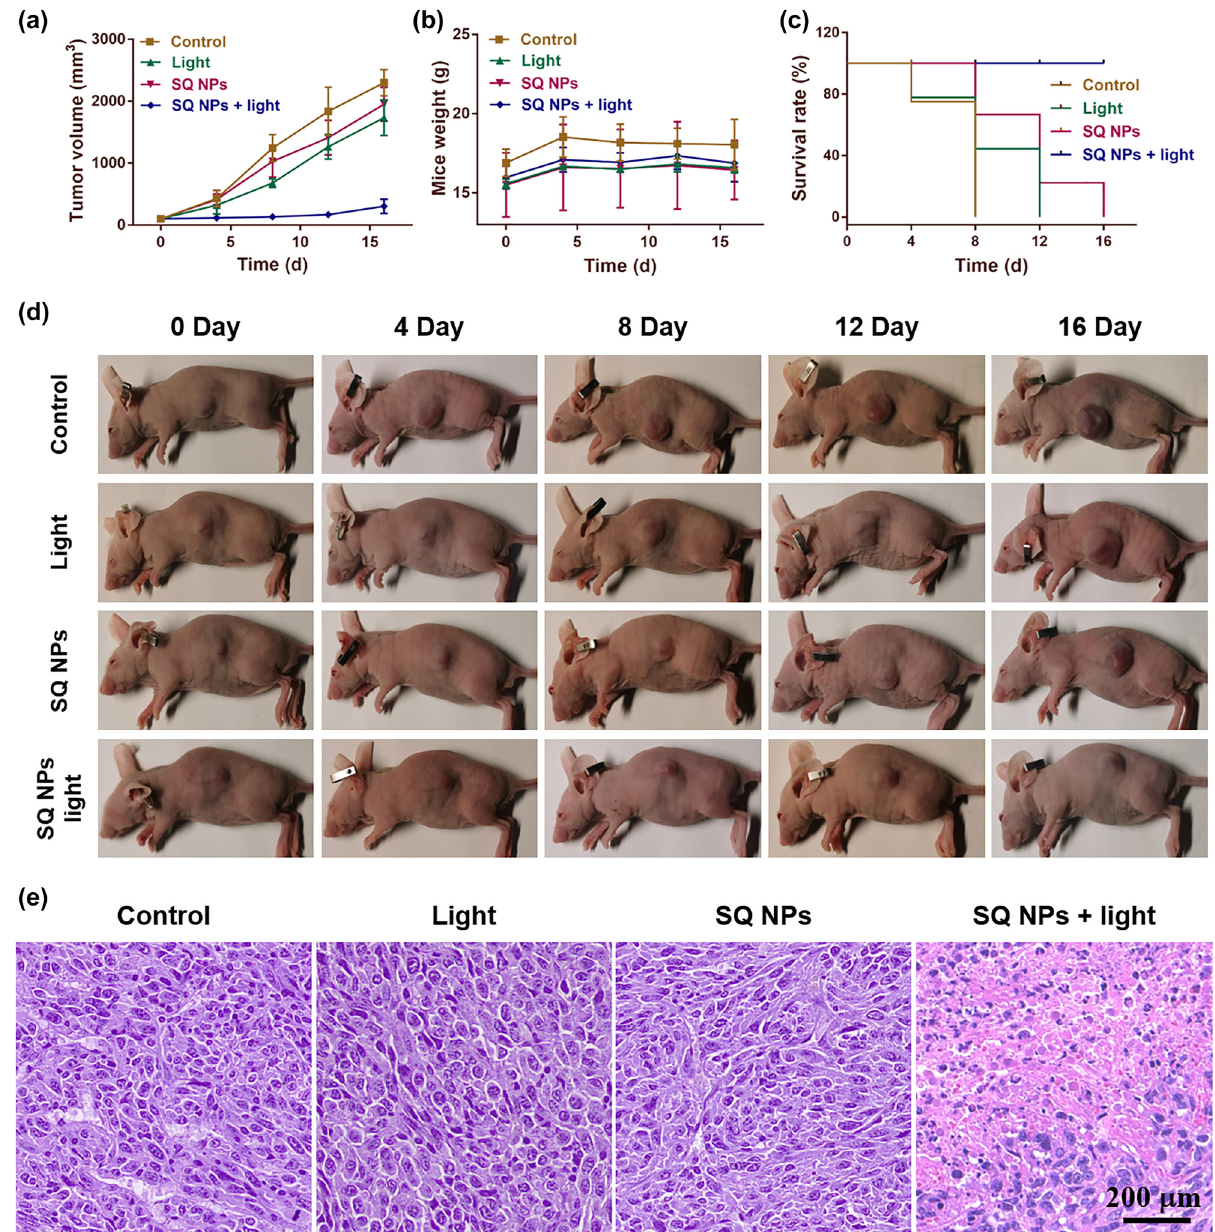
Figure 5: In vivo PDT. (a) Tumor volume. (b) Mice weight. (c) Mice survival. (d) Tumor size. (e) Tumor section staining of mice with various treatments. The scale is 200 μ